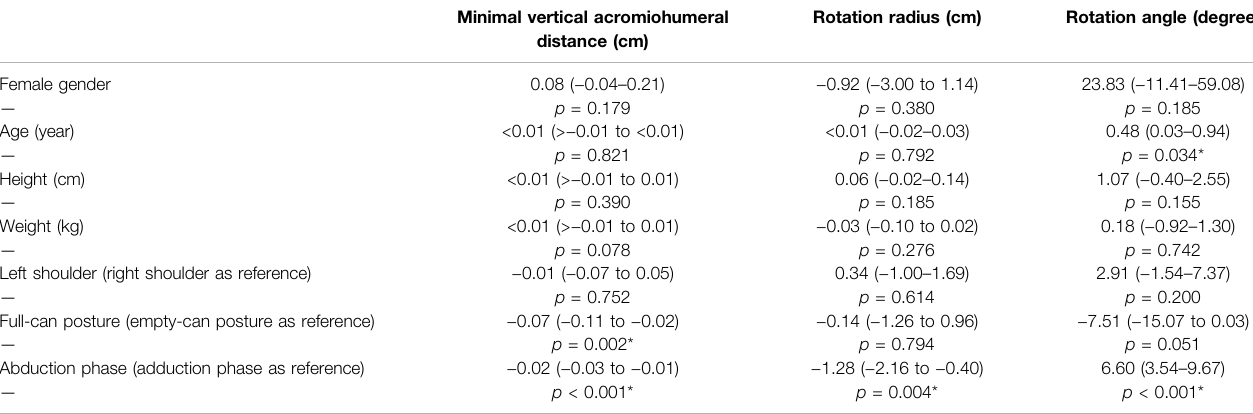
TABLE 2 | Association of the minimal vertical acromiohumeral distance, rotation radius and rotation angle of the humeral head with gender, age, body status and shoulder laterality, shoulder postures and motion phases. Minimal vertical acromiohumeral Rotation radius (cm) Rotation angle distance (cm)